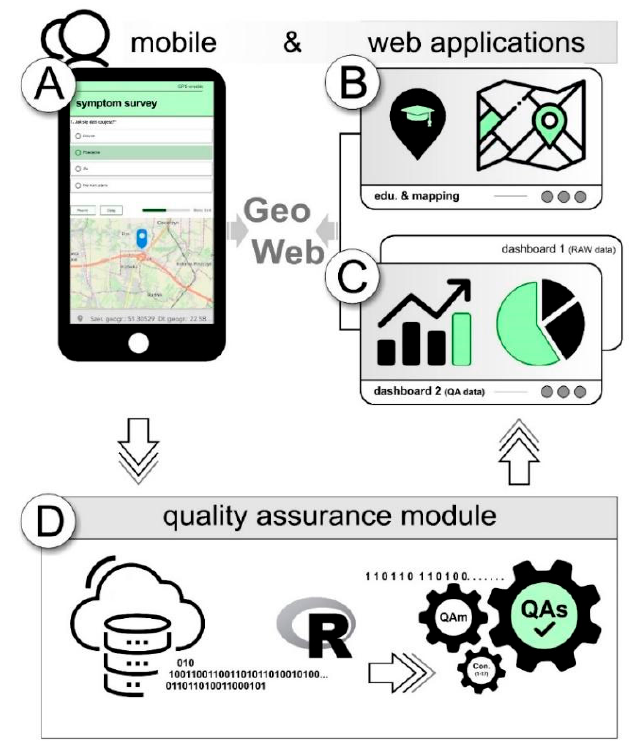
Figure 3. Geospatial web architecture implemented for the APSM project: ( A ) mobile survey app for field data collection, ( B ) web app with educational and training materials, ( C ) dashboard app for monitoring the data collection process and presenting APSM results, and ( D ) quality assurance module .